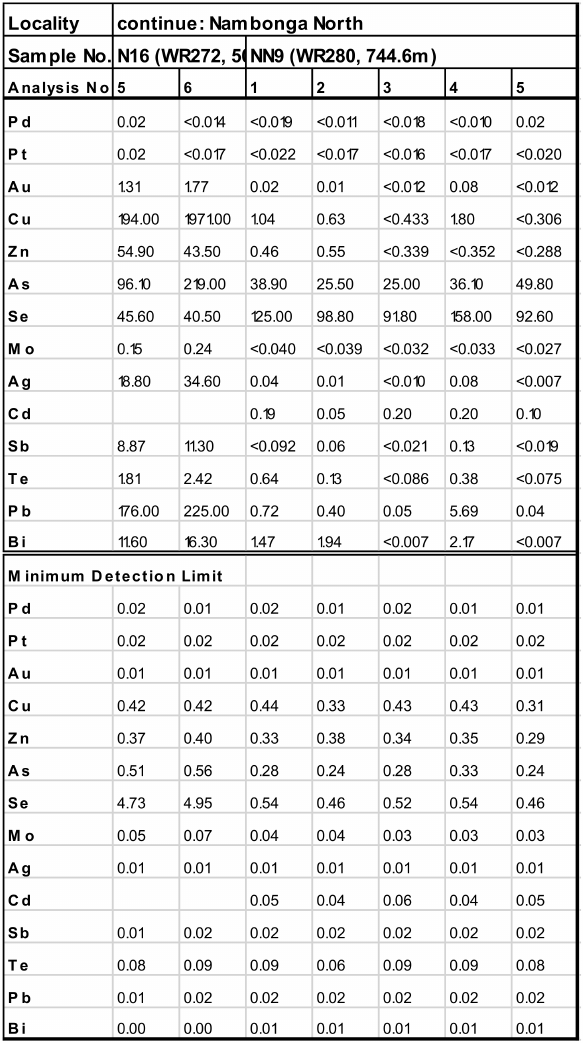
Figure A1. LA-ICPMS trace element results of pyrite (all results are in